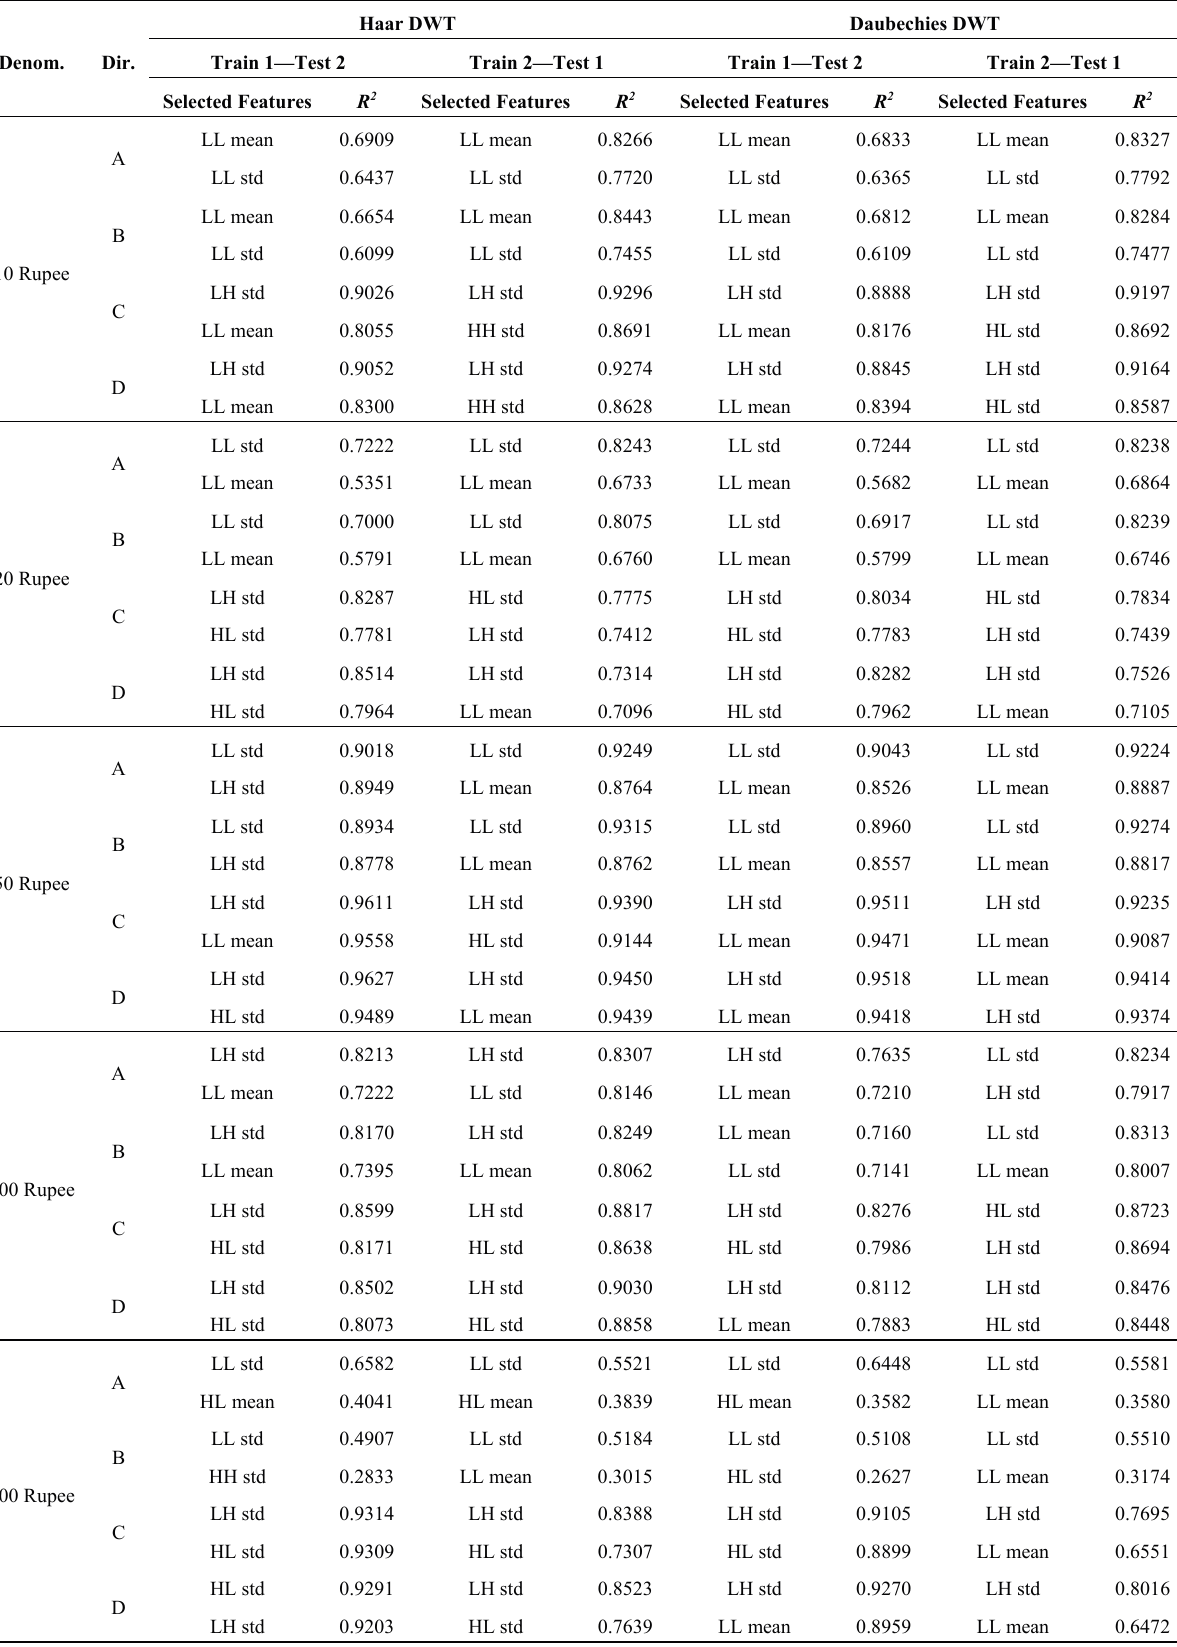
Table 3. Experimental results of DWT features selection based on linear regression. ( Denom . and Dir . are denominations and directions, respectively. Std indicates standard deviation.)